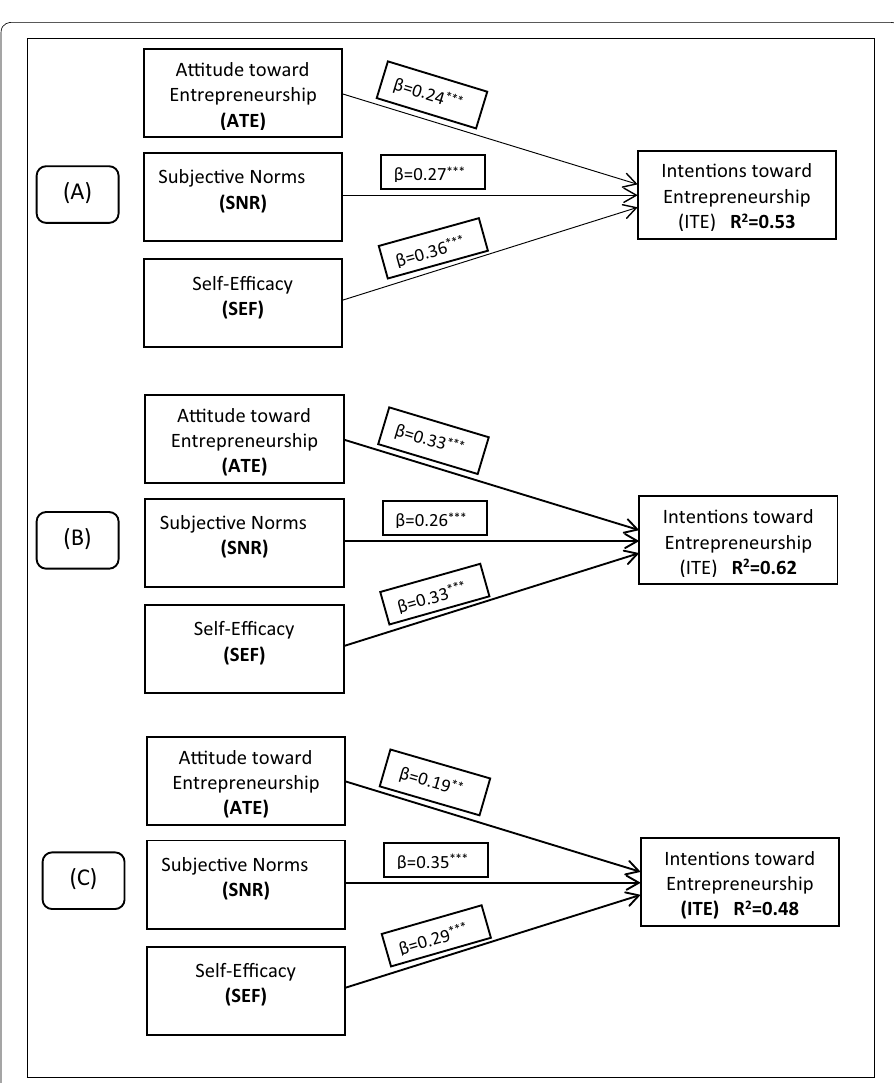
Fig. 2 Structural model and hypothesis testing (combine group A, treatment group B, and control group C)